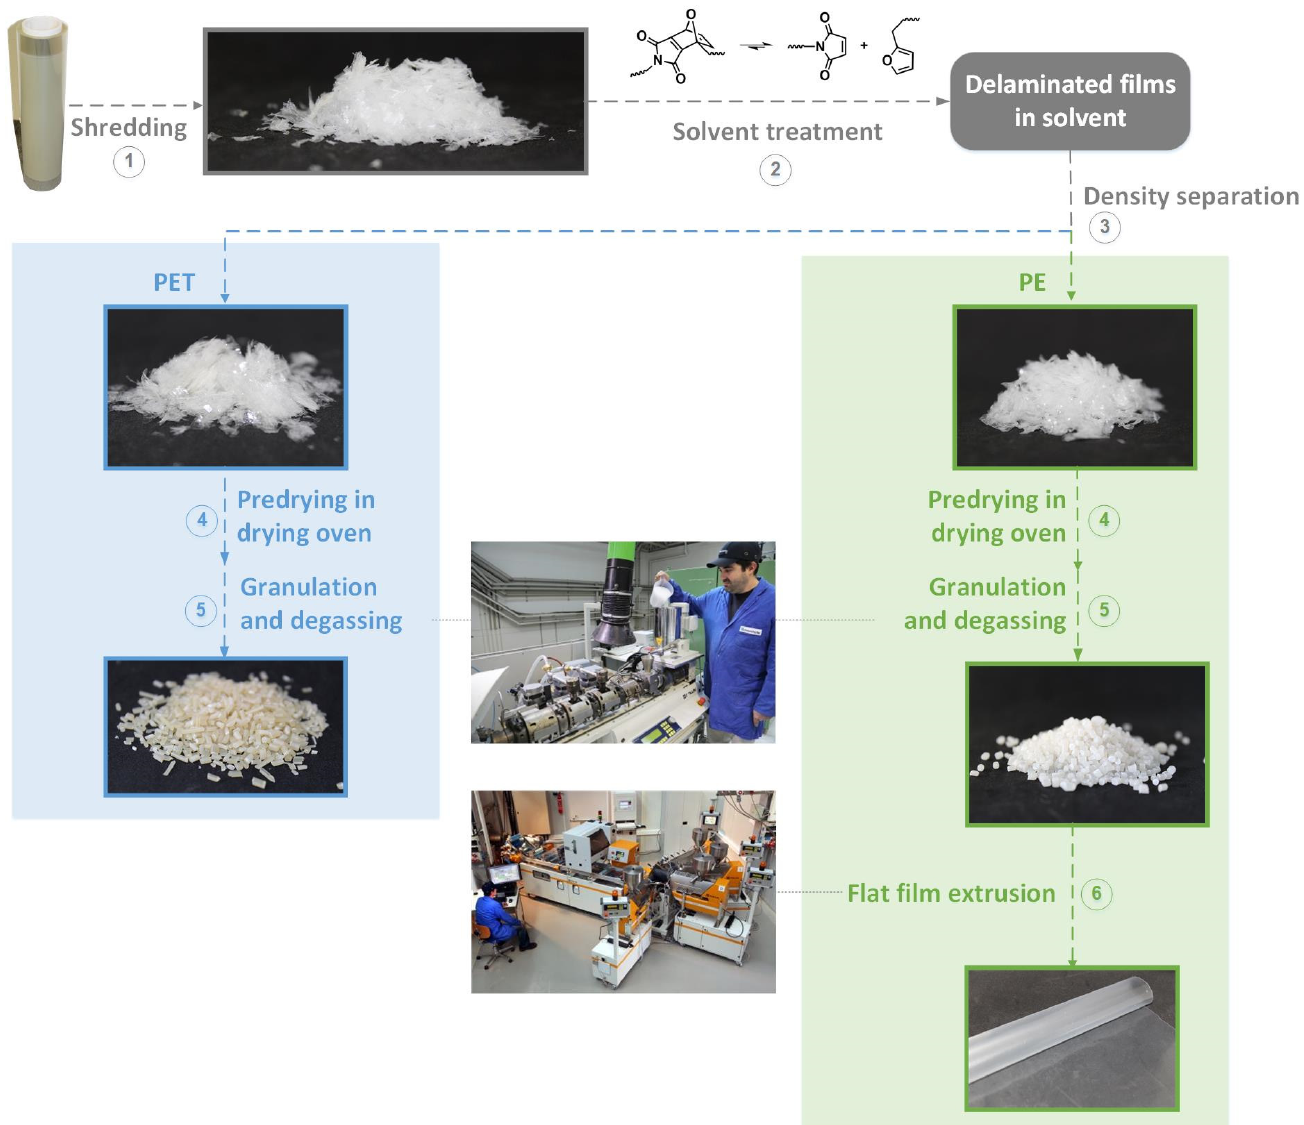
Figure 11. Overview of the individual steps of the recycling